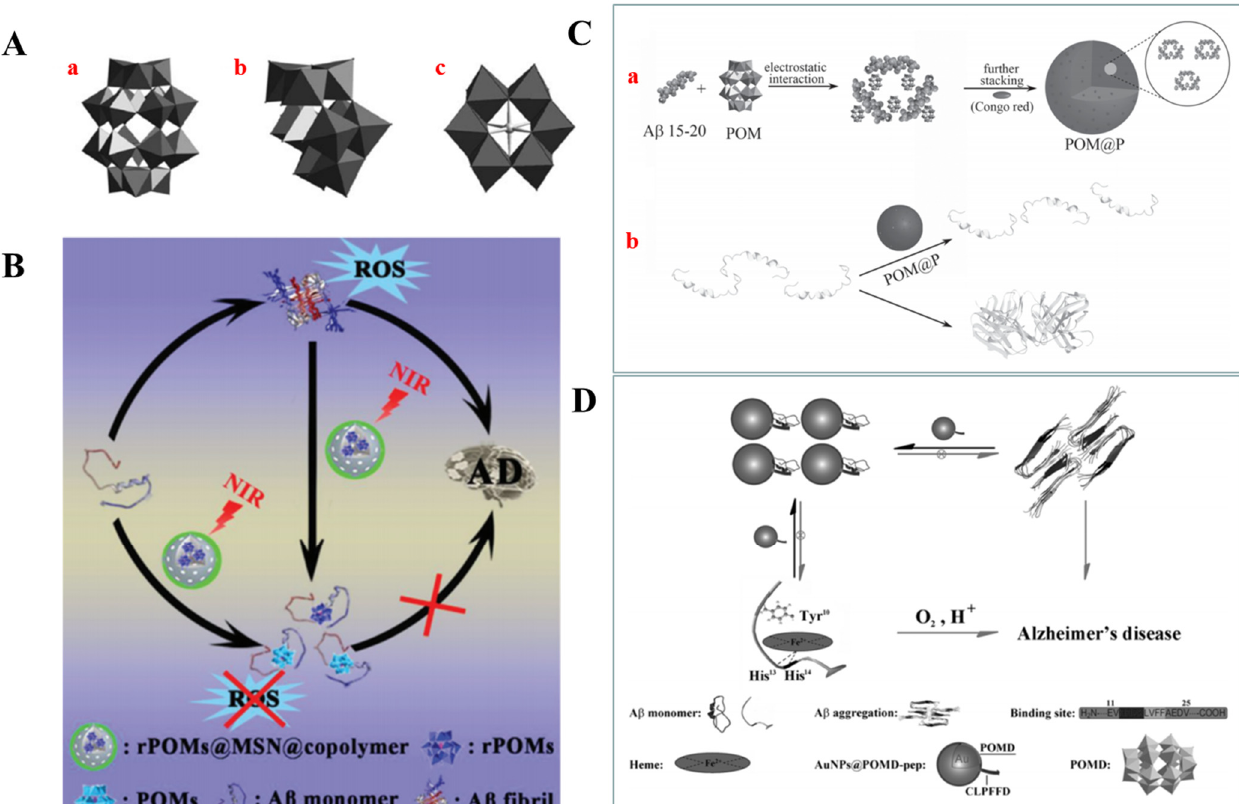
Figure 8. ( A ) Schematic of the structures of typical polyoxometalates: (a) Wells–Dawson structure, K 8 [P 2 CoW 17 O 61 ]; (b) trivacant Keggin structure, α -Na 9 H-[SiW 9 O 34 ]; (c) Anderson structure, Na 5 [IMo 6 O 24 ]. Reprinted with permission from reference [117]. Copyright 2011 Wiley-VCH. ( B ) Schematic of the NIR-responsive rPOMDs@MSNs@copolymer acting as a multifunctional photothermal agent for the treatment of AD. Reprinted with permission from reference [125]. Copyright 2018 Wiley-VCH. ( C ) Schematic of the peptide–POM conjugates used for AD treatment. (a) The schematic illustration of self-assembly of A β 15-20 and POM to hybrid spheres. (b) The assembled peptide and POM nanoparticles can effectively inhibit A β 1-40 aggregation. Reprinted with permission from reference [126]. Copyright 2013 Wiley-VCH. ( D ) Schematic of the A β pathway influenced by AuNPs@POMD–peptide. Reprinted with permission from reference [127]. Copyright 2015 Wiley-VCH.